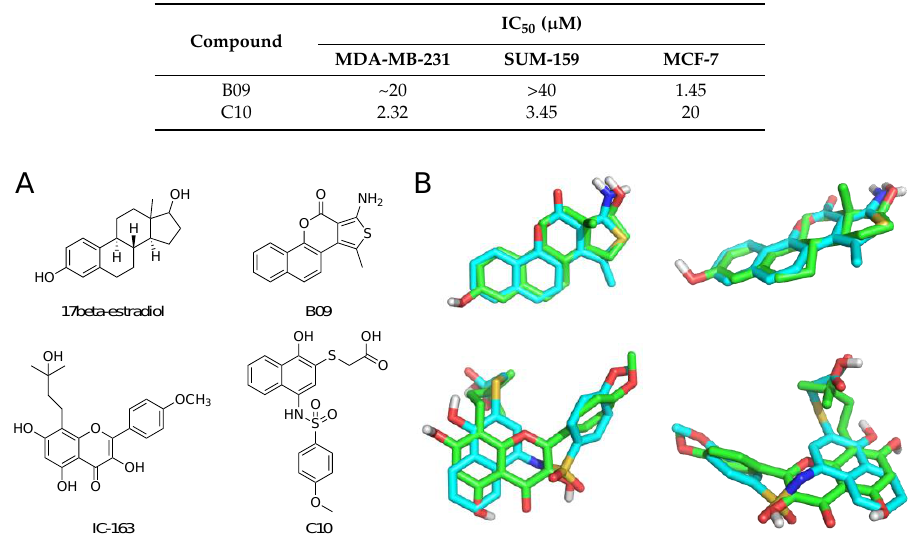
Figure 3. ( A ) Structures of 17β -estradiol, B09 , IC-163 and C10 . ( B ) Structure alignment of B09 with 17β -estradiol and of C10 with IC-163 .